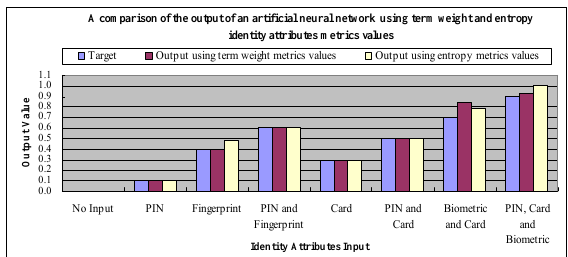
A comparison of the output values generated by an artificial neural network information fusion technique using term weight and entropy identity attributes metrics values.